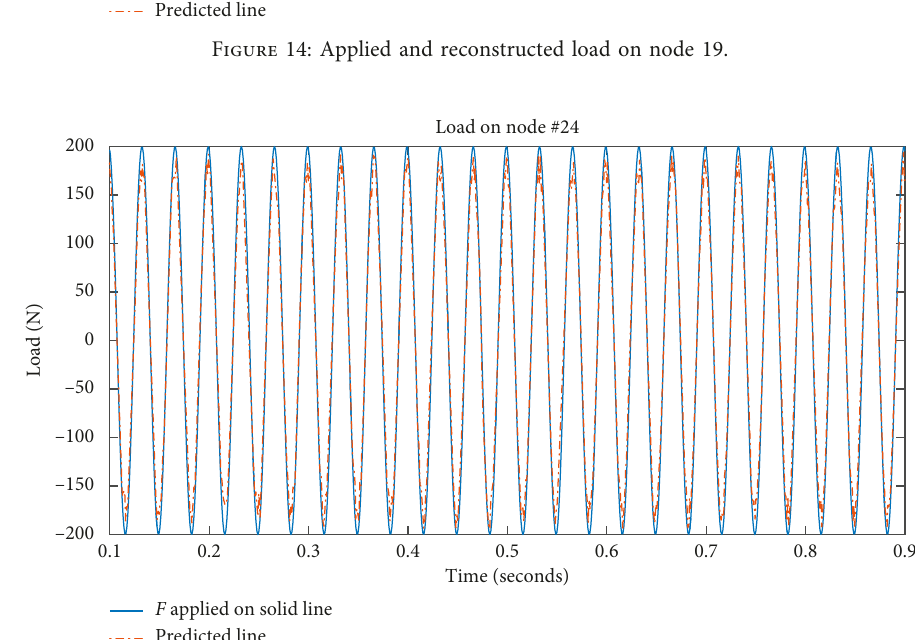
Figure 15: Applied and reconstructed load on node